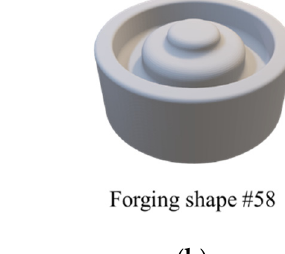
Figure 5. ( a ) Schematic diagram of the geometrical features of the forging shapes, ( b ) forging shape #58 (example).